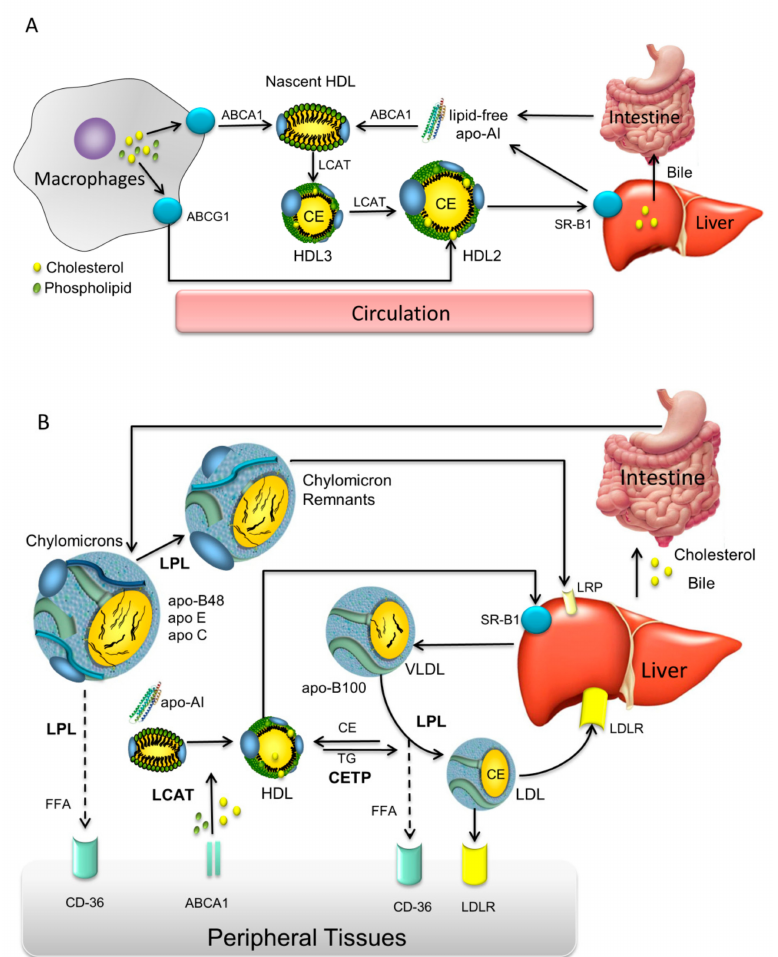
Figure 1. Schematic diagram of high density lipoprotein (HDL) metabolism in the circulatory system. ( A ) apolipoprotein AI (apoA-I) is synthesized in the liver and intestine in lipid free form. apo-AI becomes rapidly lipidated with phospholipids and cholesterol via the hepatocyte ATP-binding cassette A1 (ABCA1) transporter to form discoidal nascent HDL. In peripheral tissues nascent HDL